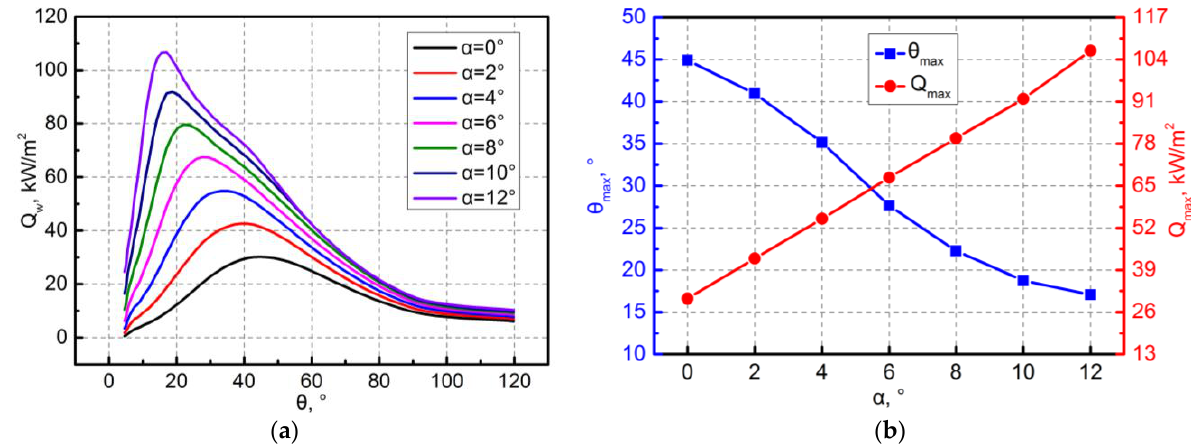
Figure 6. Analysis results of windward side: ( a ) heat flux; ( b ) peak heat flux.